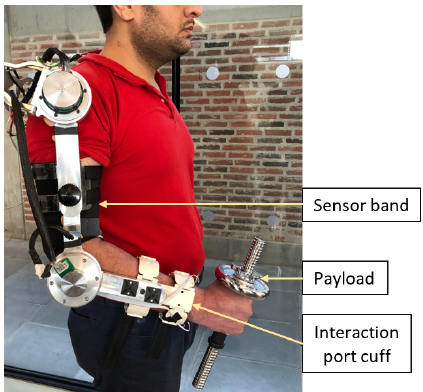
Figure 9: Upper-body exoskeleton for physical assis- tance